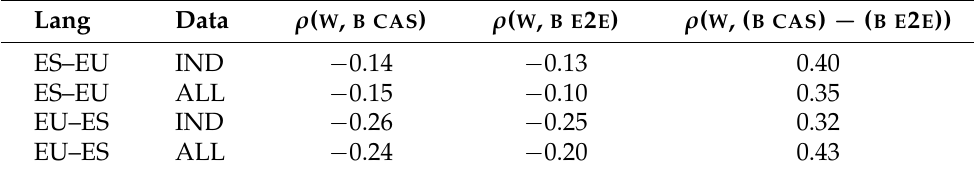
Table 17. Pearson correlation between WER ↓ (W) and BLEU ↑ (B) scores for the selected Cascade (CAS) and End-to-End (E2E) models. All results were statistically significant ( p <